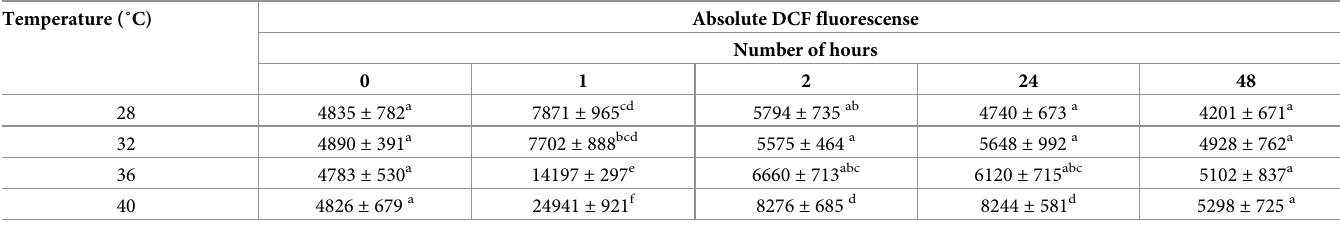
Table 2. ROS production of K . alvarezii incubated at different temperatures.